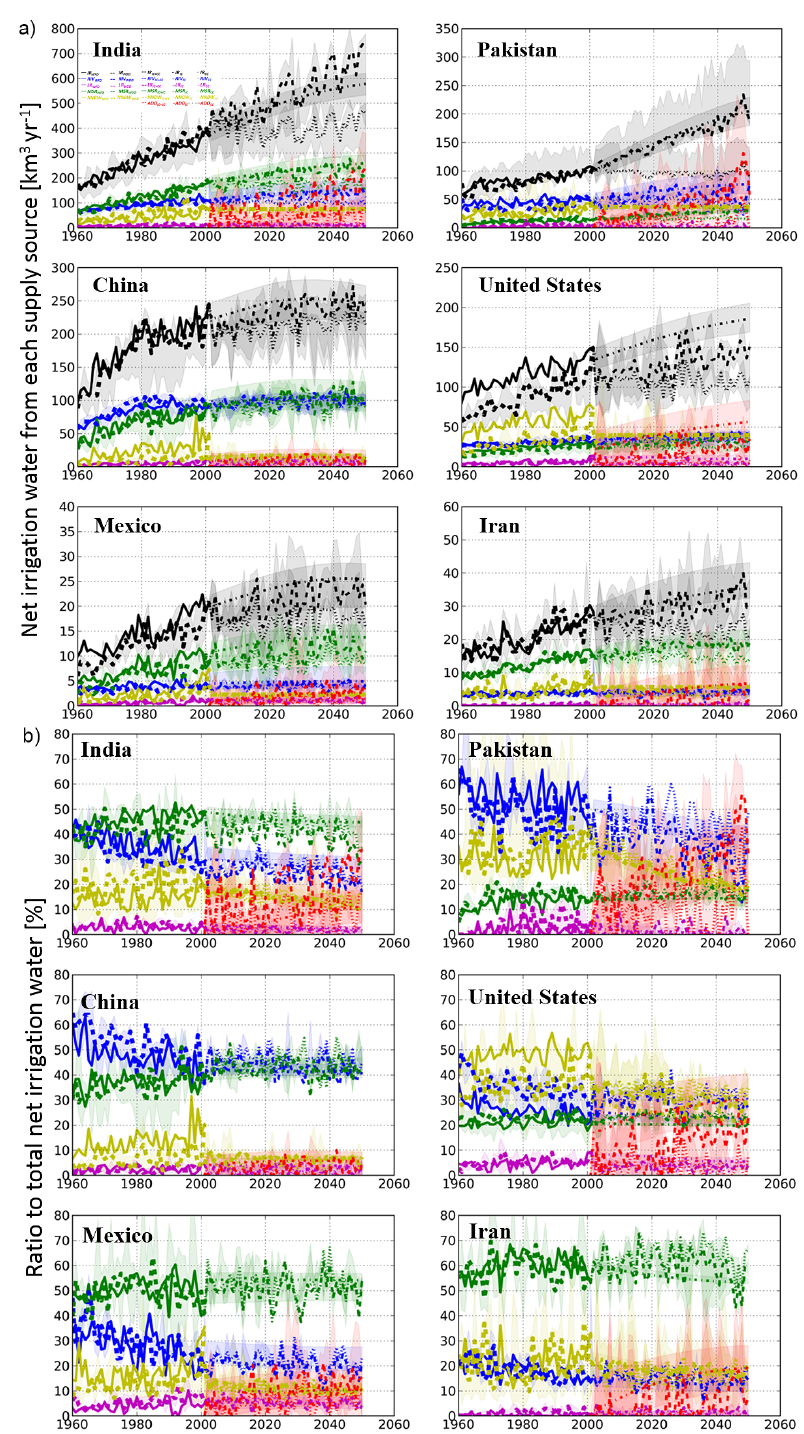
Figure 7. Annual changes in net irrigation water requirements from four water supply sources (RIV, LR, MSR and NNBW) using the WFD and WDD data sets during 1960–2001, and global net irrigation water requirements from five water supply sources according to the IC simulation (RIV IC , LR IC , MSR IC , NNBW IC and ADD IC ), the CC simulation (RIV CC , LR CC , MSR CC , NNBW CC and ADD CC ) and the IC + CC simulation (RIV IC+CC , LR IC+CC , MSR IC+CC , NNBW IC+CC and ADD IC+CC ) for 2002–2050 in India, Pakistan, China, the United States, Mexico and Iran (a) . The percentage contribution of the different water supply sources to IR for the six countries (b) . In the past and future periods, results of the ensemble median for the WDD data set from the three GCMs are provided. Outer shades show the maximum and minimum for all the meteorological forcing